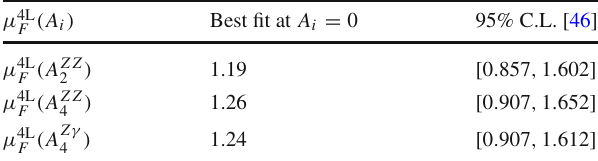
Table1 SummaryofCMSratemeasurementsofH → 4Lfromggh+ttH production channels [45,46]. Each measurement is optimized with respect to a particular anomalous HVV coupling as indicated. How- = 0 ever, the fit is performed assuming A V i